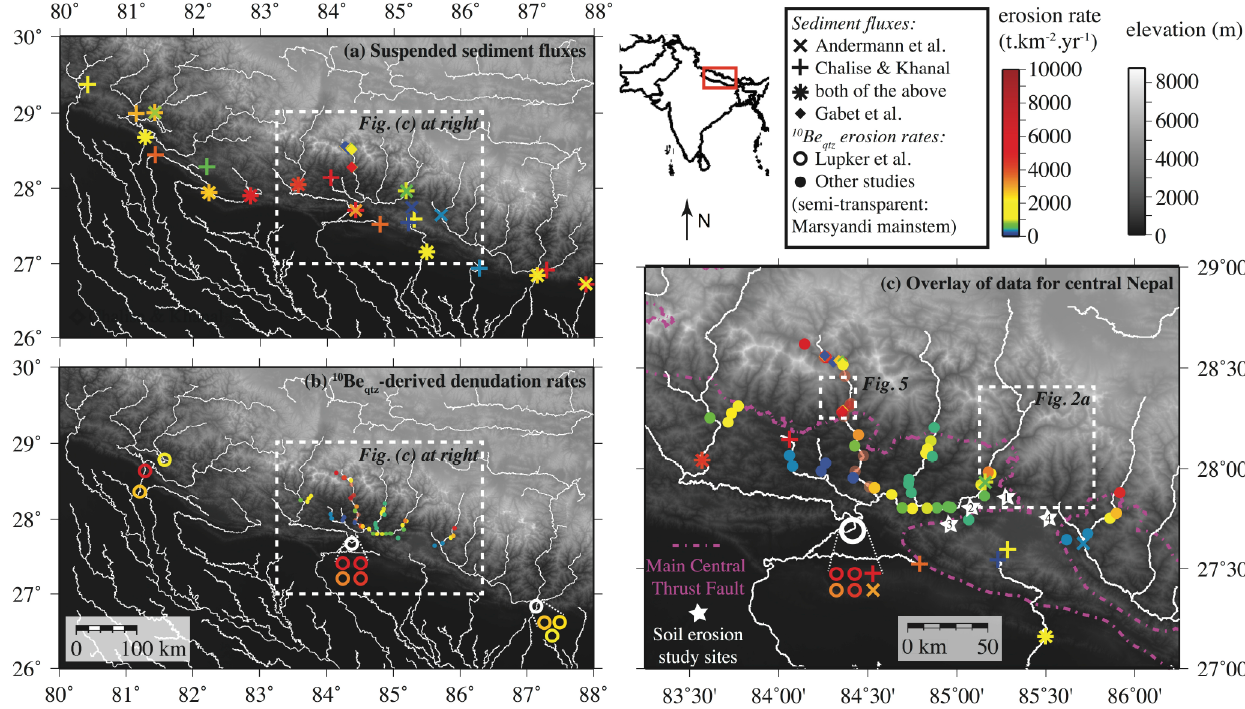
Figure 1. Map of Nepal showing erosion rate data collected in previous studies. Grayscale background shows elevation from SRTM digital elevation map at ∼ 90m resolution. Data points are color-coded by erosion rate. (a) Sediment fluxes from Chalise and Khamal (1997) and Andermann et al. (2012), with overlain symbols representing sites with data from both studies. (b) Denudation rates determined from 10 Be qtz from Godard et al. (2012), Godard et al. (2014), Lupker et al. (2012), and Wobus et al. (2005). White circles are expanded to show data collected from multiple times or grain sizes by Lupker et al. (2012). (c) Magnified scale of central Nepal region showing data from (a) and (b) along with location of several previous studies of agricultural soil erosion identified from published literature: (1) Likhu Khola (Gardner and Jenkins, 1995; location of this study), (2) Kulekhani (Upadhaya et al., 1991), (3) Pokhare Khola (Tiwari et al., 2008), and